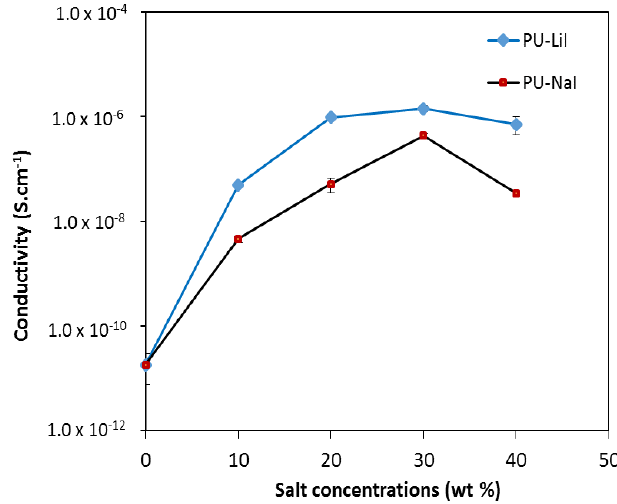
Figure 3. Conductivity of PU based polymer electrolytes with different wt% of LiI and